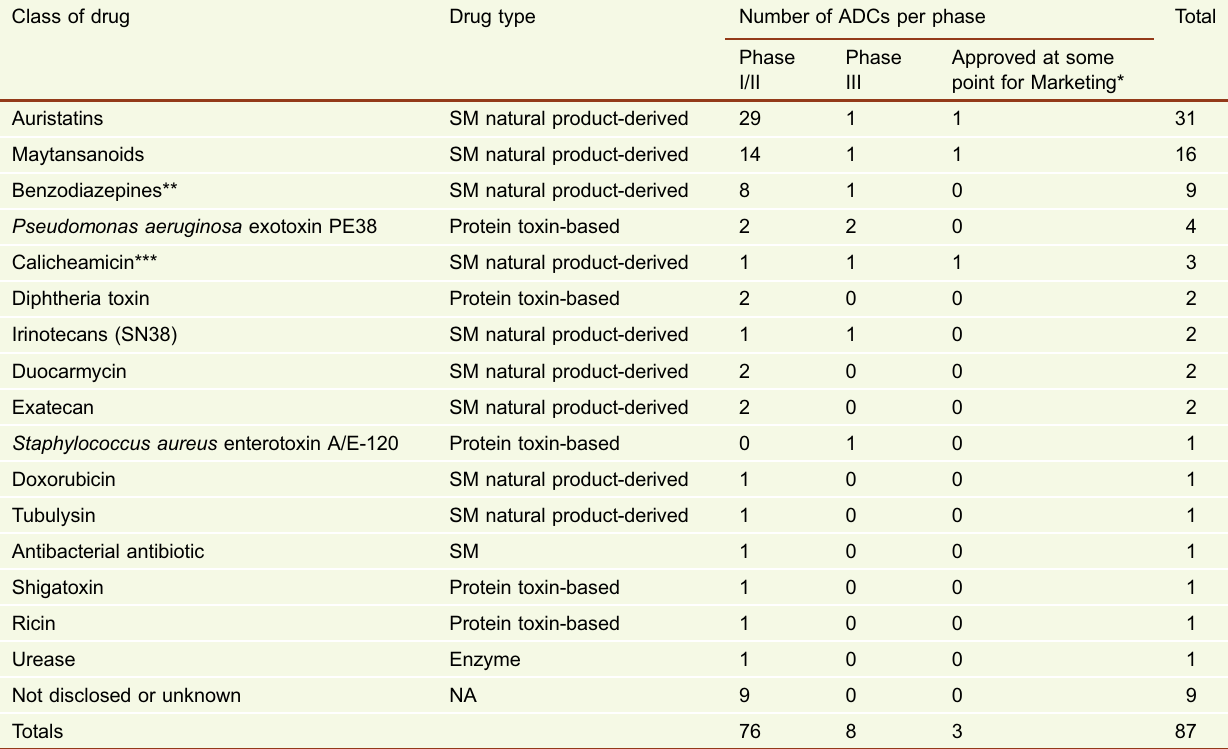
Table 9. Classes of drugs currently being employed in antibody drug conjugate candidates* Class of